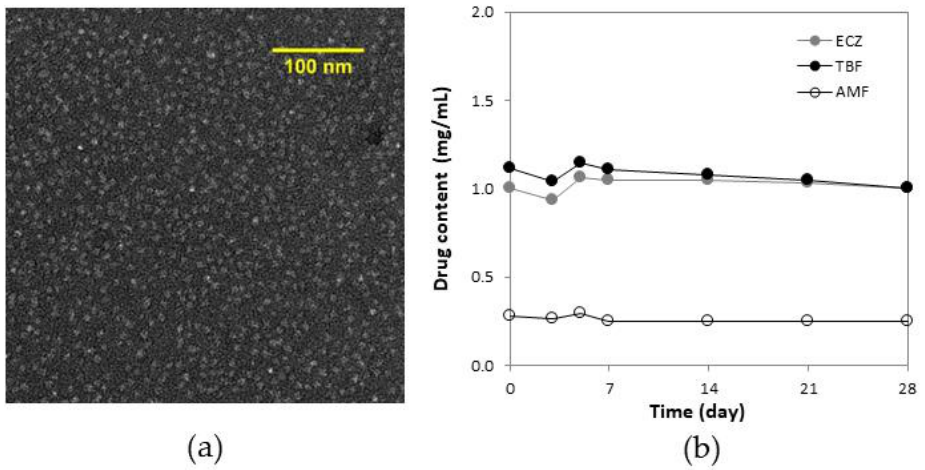
Figure 2. Characterization of the antifungal “tri-therapy”: ( a ) morphology under TEM (magnification 62,000 × ); ( b ) formulation stability by monitoring drug content as a function of time during storage for 4 weeks at 4 °C ( n = 3).